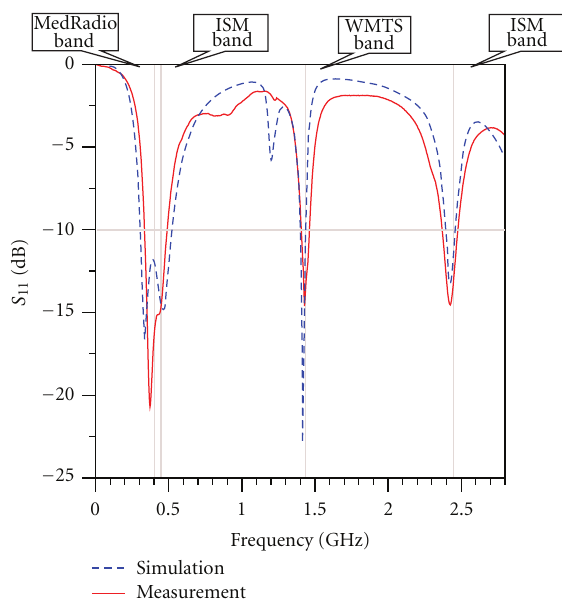
Figure 11: Simulated and measured return loss for the proposed antenna implanted in ground pork skin.